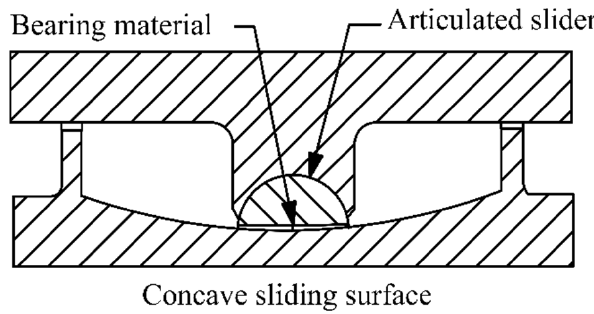
Figure 2. Schematics of a typical friction pendulum bearing.